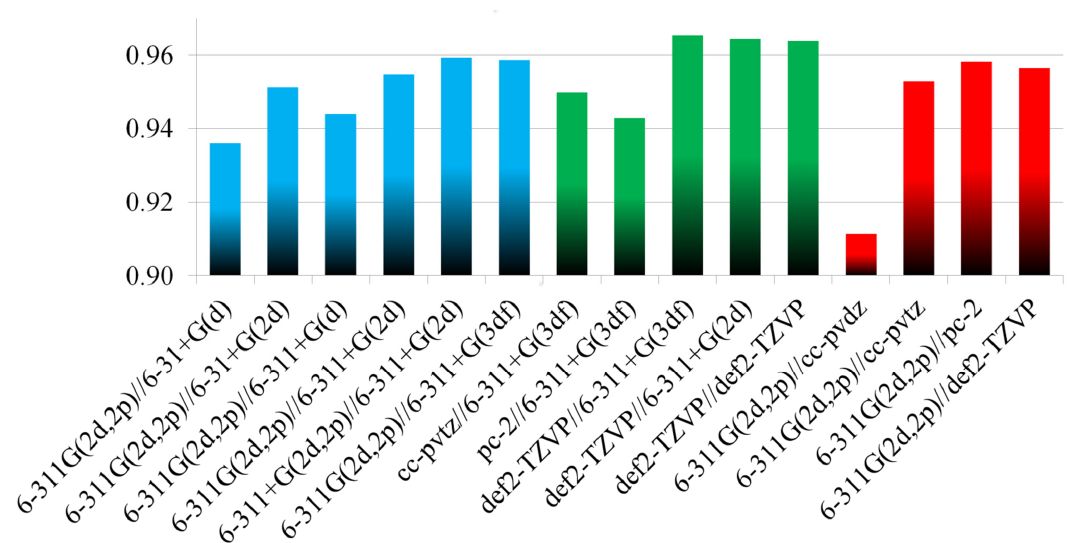
Figure 3. R 2 dependence for the “training” set of Pd-complexes on combinations used in calculations. In all cases, the functional was fixed to the PBE0.